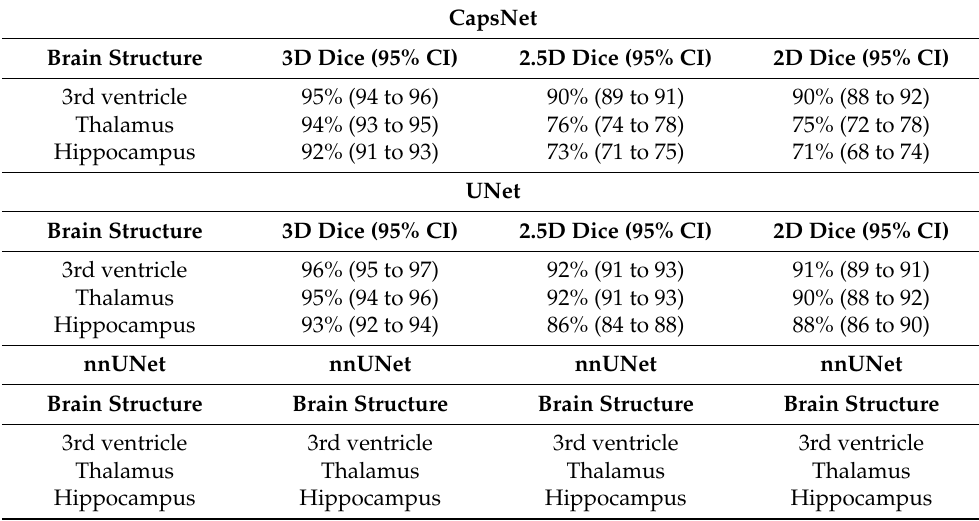
Table 2. Comparing the segmentation accuracy of 3D, 2.5D, and 2D approaches across three auto- segmentation models to segment brain structures. The three auto-segmentation models included CapsNet, UNet, and nnUNet. These models were used to segment three representative brain structures: third ventricle, thalamus, and hippocampus, which respectively represent easy, medium, and difficult structures to segment. The segmentation accuracy was quantified by Dice scores over the test (114 brain